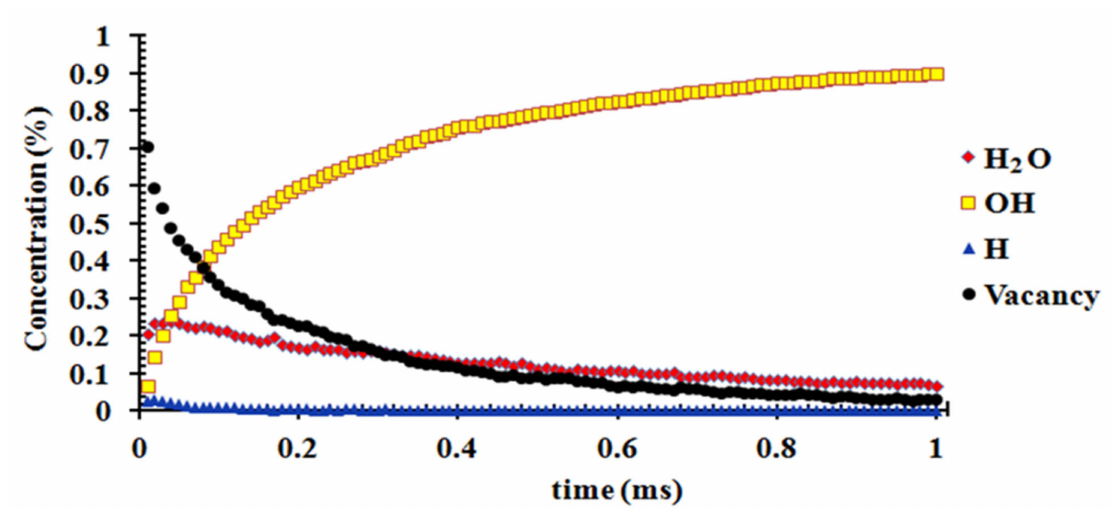
Figure 12. Relative concentration variance of H 2 O, OH, H on the molybdenite (110) surface in one microsecond at 298